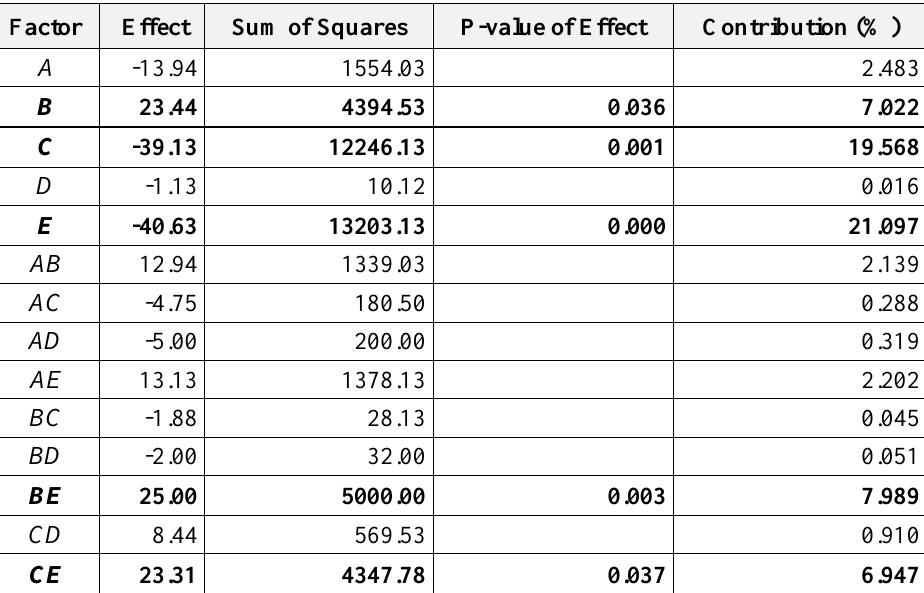
Table 3 - Evaluation of factor